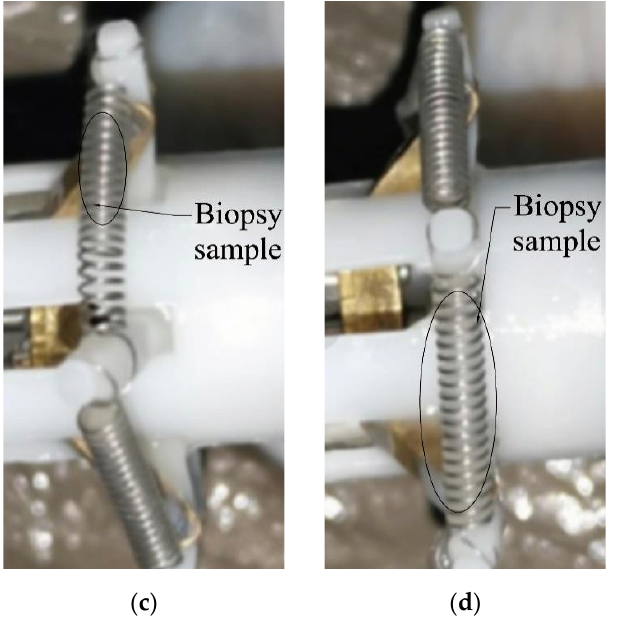
Figure 9. Situations of the biopsy sample inside a spring. ( a ) Situation 1, ( b ) Situation 2, ( c ) Situation 3, ( d ) Situation 4.